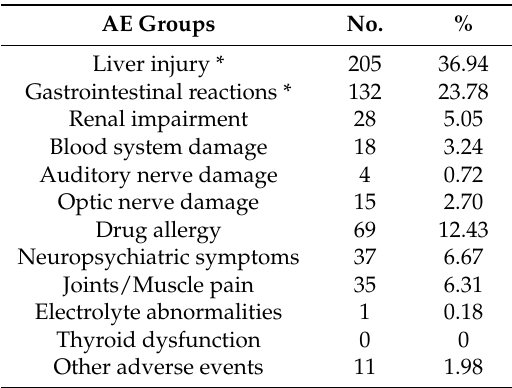
Table 2. The frequency and proportion of adverse events during anti-tuberculosis treatment.